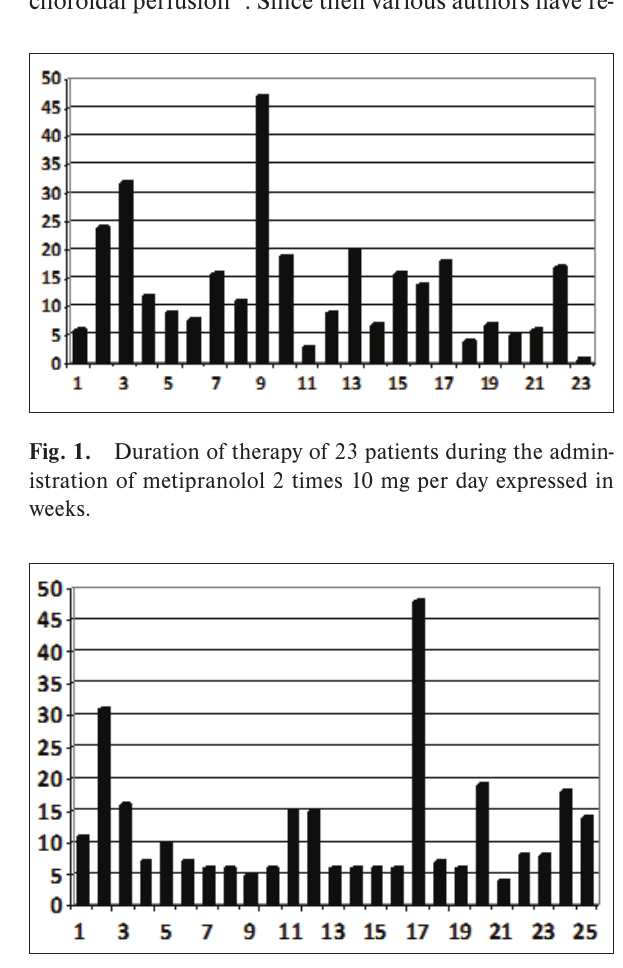
Fig. 2. Duration of therapy in 25 patients during the admin- istration of placebo expressed in